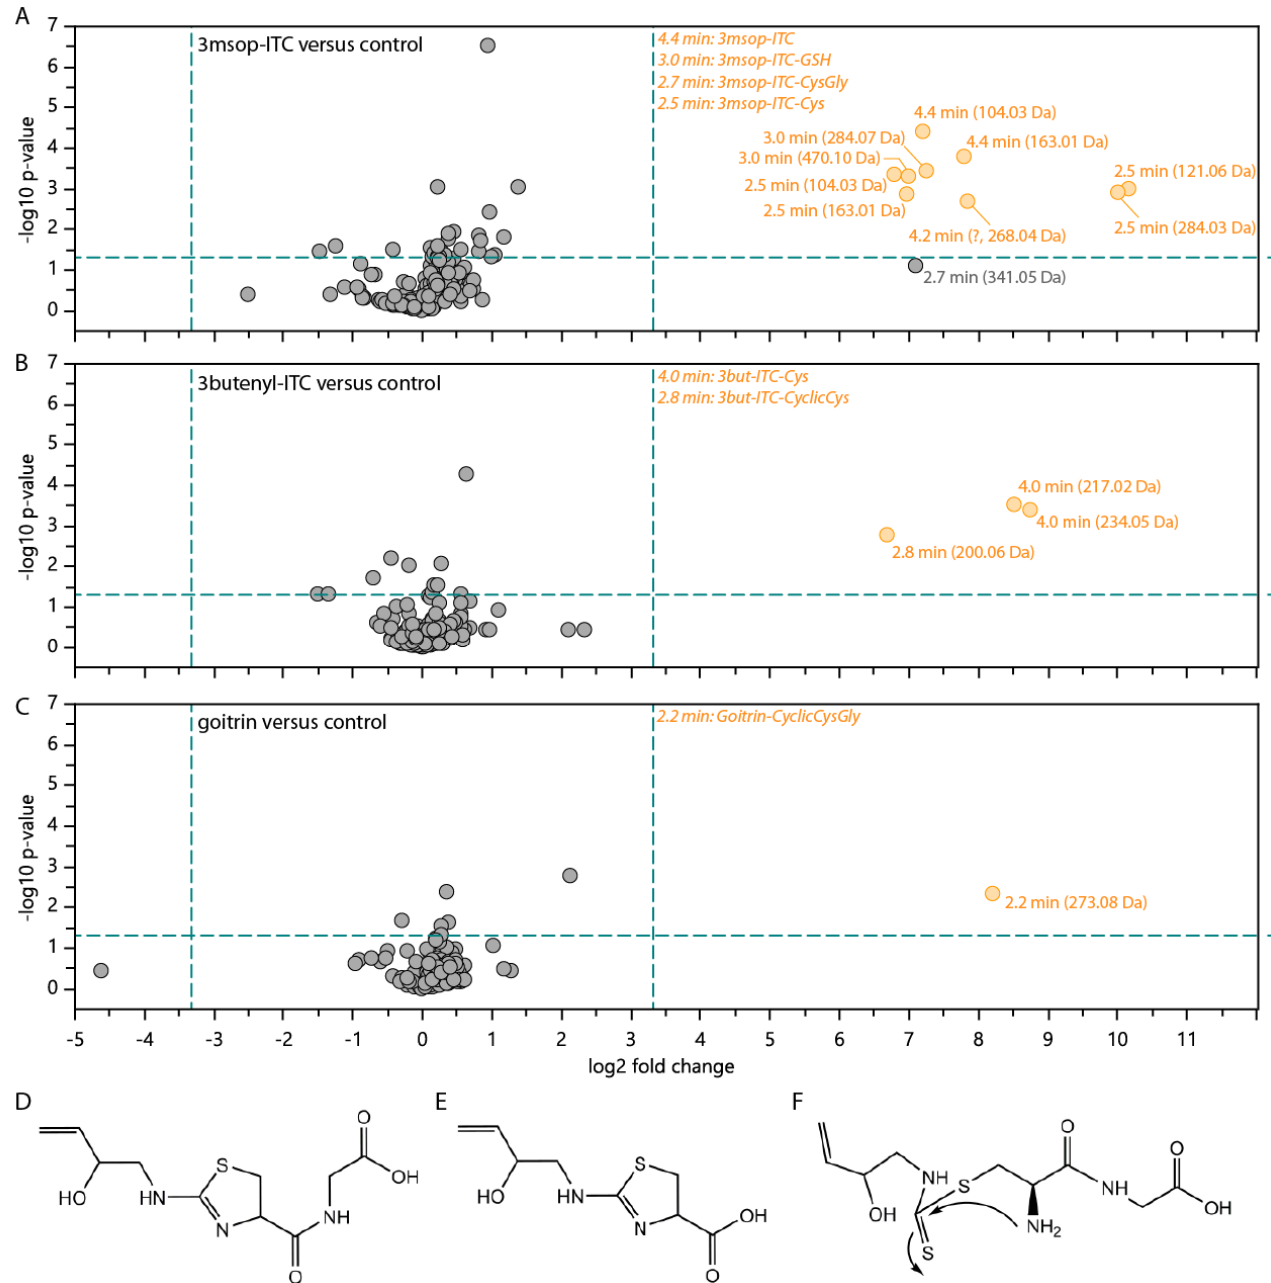
Figure 5. Glucosinolate hydrolysis products are metabolized via the mercapturic acid pathway and intramolecular cyclizations by H. armigera larvae. ( A–C ) Volcano plots of extracted LC-MS/MS features from non-targeted UHPLC-HRMS analyses indicate that the major metabolites of 3msop-ITC ( A ), 3but-ITC ( B ), and goitrin ( C ) are all formed by conjugation to glutathione (GSH), further hydrolysis of the amino acid constituents of GSH to give CysGly and Cys conjugates, and intramolecular cyclizations to give cyclic conjugates. The proposed goitrin metabolite ( D ) corresponds to the MS feature at 2.2 min in ( C ), while a signal corresponding to the proposed metabolite ( E ) was detectable in manually extracted ion chromatograms from faeces extracts but was too small to be extracted automatically by the software. The proposed formation of these cyclic metabolites is shown in ( F ).